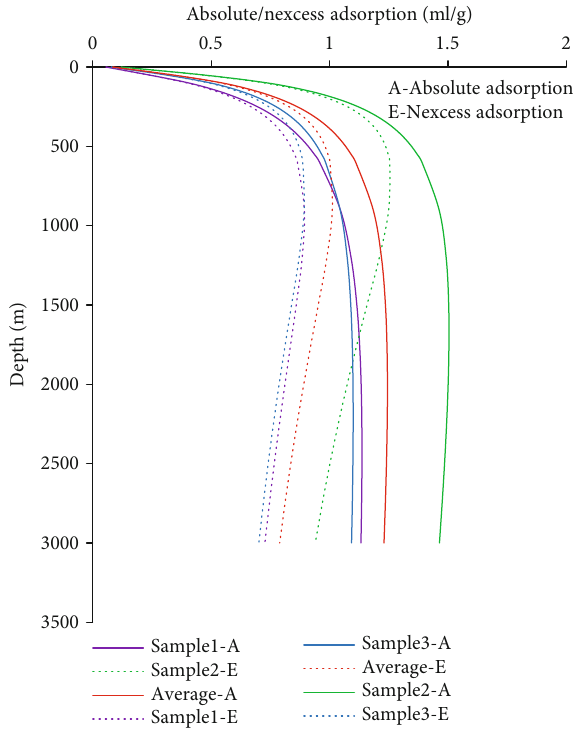
Figure 8: Methane adsorption capacity of mineral composition in three samples under geological